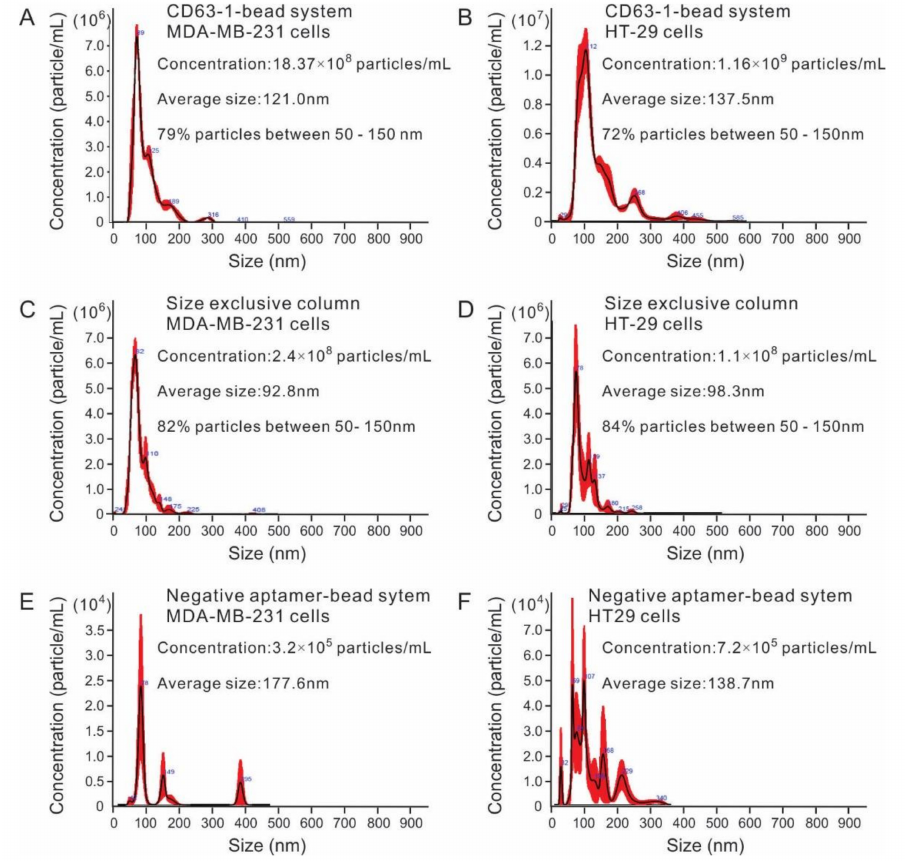
Figure 7. Analysis of exosomes collected by di ff erent methods. ( A , B ) NTA analysis of MDA-MB-231 and HT29 exosomes isolated by bead / aptamer system; ( C , D ) NTA analysis of MDA-MB-231 and HT29 exosomes isolated by size exclusion chromatograph method; ( E , F ) NTA analysis of MDA-MB-231 and HT29 exosomes isolated by a negative aptamer (CD63-6)-based bead